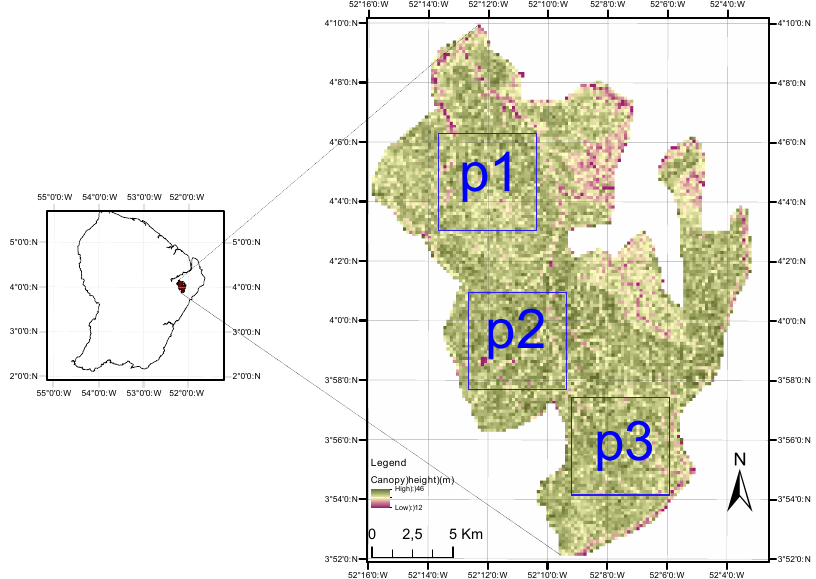
Figure 1. Map of study site location in the Regina forest, a lowland tropical rainforest in French Guiana (192 m × 192 m). Three 3782.25 ha plots (p1, p2, p3) are used to test the environmental effects in shaping forest canopy height. The remaining areas are used to test the predictive power of the environment-only models. Green colors represent taller canopy and red colors represent shorter